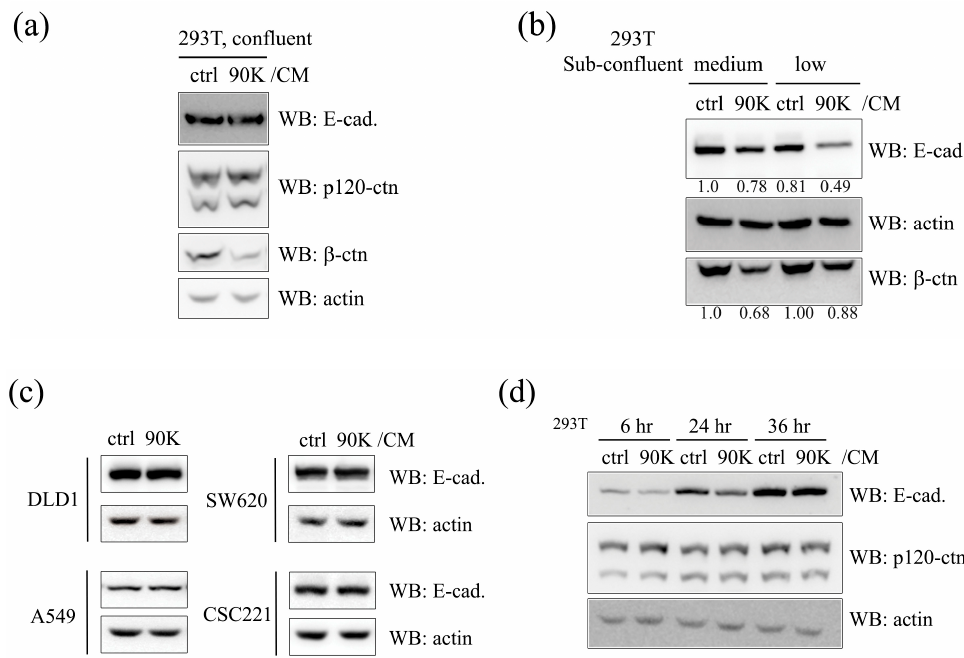
Figure 2. 90K decreases E-cadherin levels in a cell-population-dependent manner. ( a ) The effect of 90K on E-cadherin levels was decreased in confluent cells. Cells were plated to 70% confluence; treated with either ctrl/CM or 90K/CM for 16 h; and immunoblotted for E-cadherin, p120-catenin, and β -catenin; ( b ) The effect of 90K on E-cadherin levels was cell-population-dependent. Cells were plated to different confluence levels (medium, 50%; low, 30%); treated with either ctrl/CM or 90K/CM for 16 h; and immunoblotted for E-cadherin, actin, and β -catenin. The effect of 90K on β -catenin levels was also cell-population-dependent, and more evident in confluent cell populations. Actin was used as a loading control. Relative values of E-cadherin/actin and β -catenin/actin ratio in triplicate experiments are shown below the E-cadherin and β -catenin panel, respectively; ( c ) The effect of 90K on E-cadherin levels was decreased in DLD1, SW620, A549, and CSC221 cells. Cells were plated to 50% confluence, treated with either ctrl/CM or 90K/CM for 16 h, and immunoblotted for E-cadherin and actin; ( d ) The effect of 90K on E-cadherin levels was dependent on treatment time. Cells were plated to low confluence; treated with either ctrl/CM or 90K/CM for the indicated times; and immunoblotted for E-cadherin, p120-catenin, and actin.